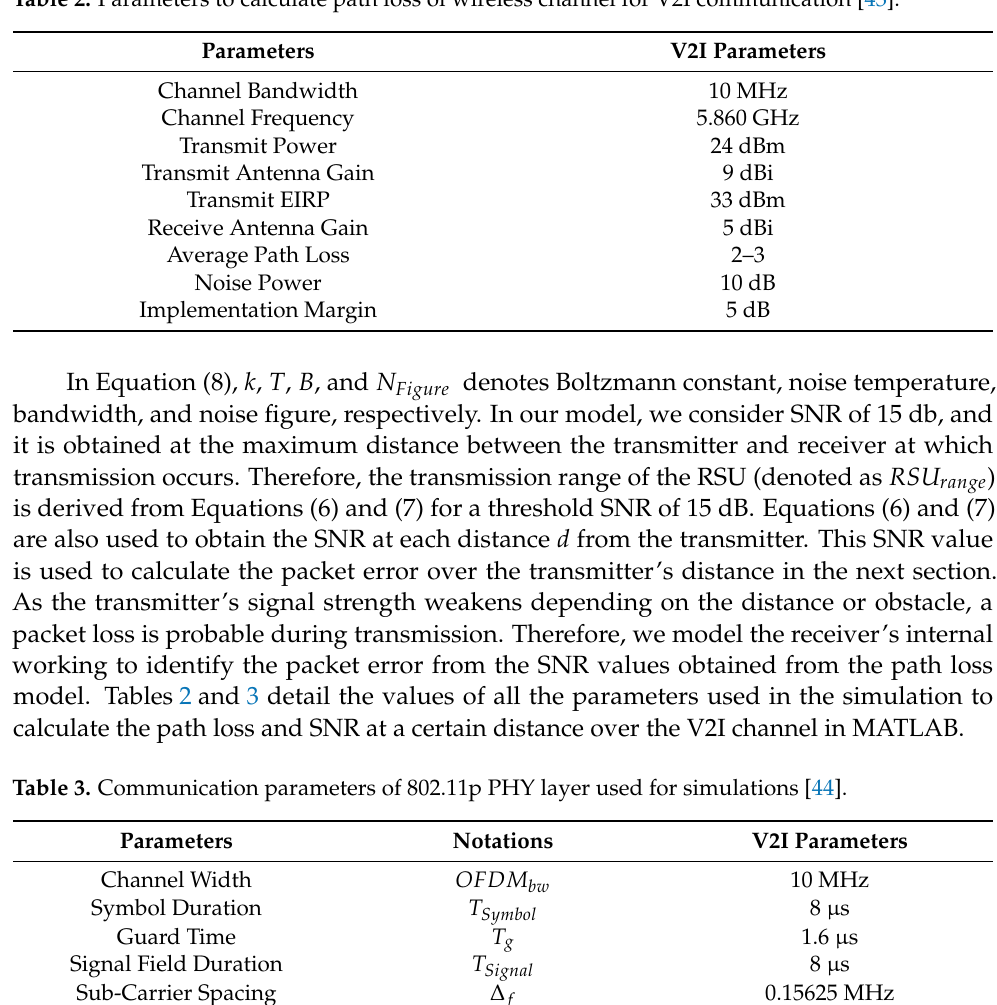
Table 2. Parameters to calculate path loss of wireless channel for V2I communication [43].